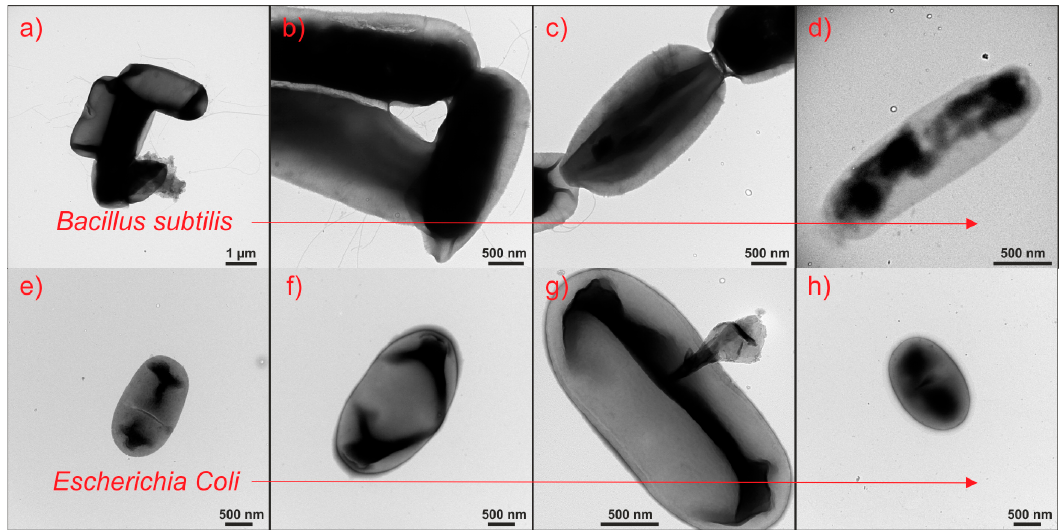
Figure 7. TEM images of bacteria after 60 min of various processes: ( a , e ) reference bacteria ( b , f ) light switched off, bacteria present, photocatalyst present, ( c , g ) light switched on, bacteria present, photocatalyst absent and ( d , h ) light switched on, bacteria present, photocatalyst present.